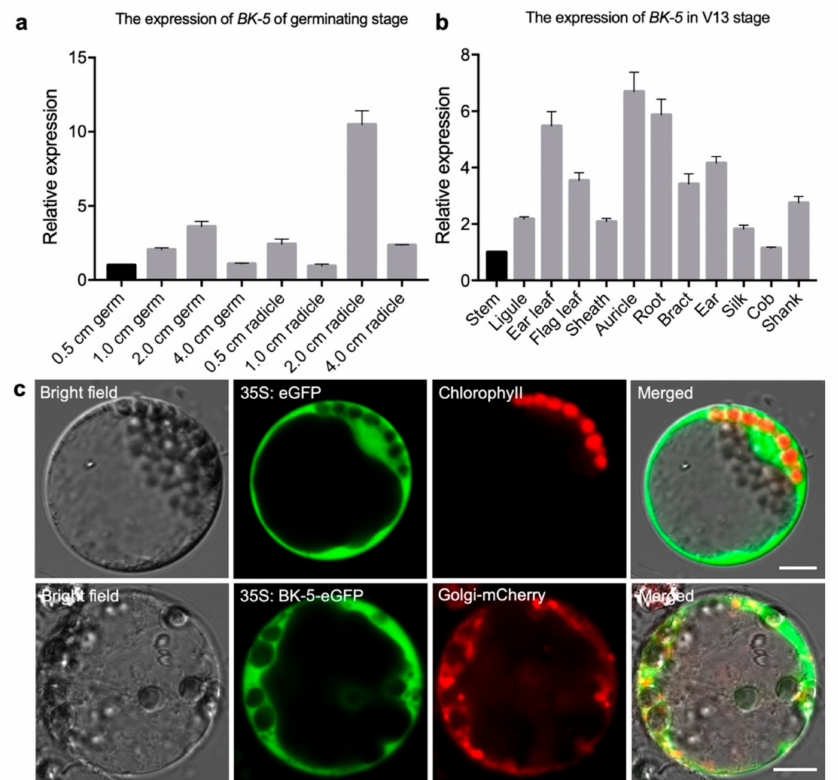
Figure 6. Expression analysis and Subcellular localization of BK-5 . ( a ) The expression of BK-5 in 0.5, 1, 2, and 4 cm roots and buds of different germinating stages. BK-5 high expression in 2-cm roots and buds. ( b ) The expression of BK-5 in different tissues of V13 stage. Samples of stem, ligule, sheath, and auricle were derived from tenth section. BK-5 was constitutive expressed in all the tissues. 18S ribosomal RNA (rRNA) was used as an internal control. For each RNA sample, three technical replicates of two tissue samples were performed per stage. Error bars represent standard deviation. ( c ) Subcellular localization of BK-5 in maize protoplasts. From left to right were bright field, green fluorescence, chloroplast/mCherry fluorescence, fusion image. Scale bar: 10 µ